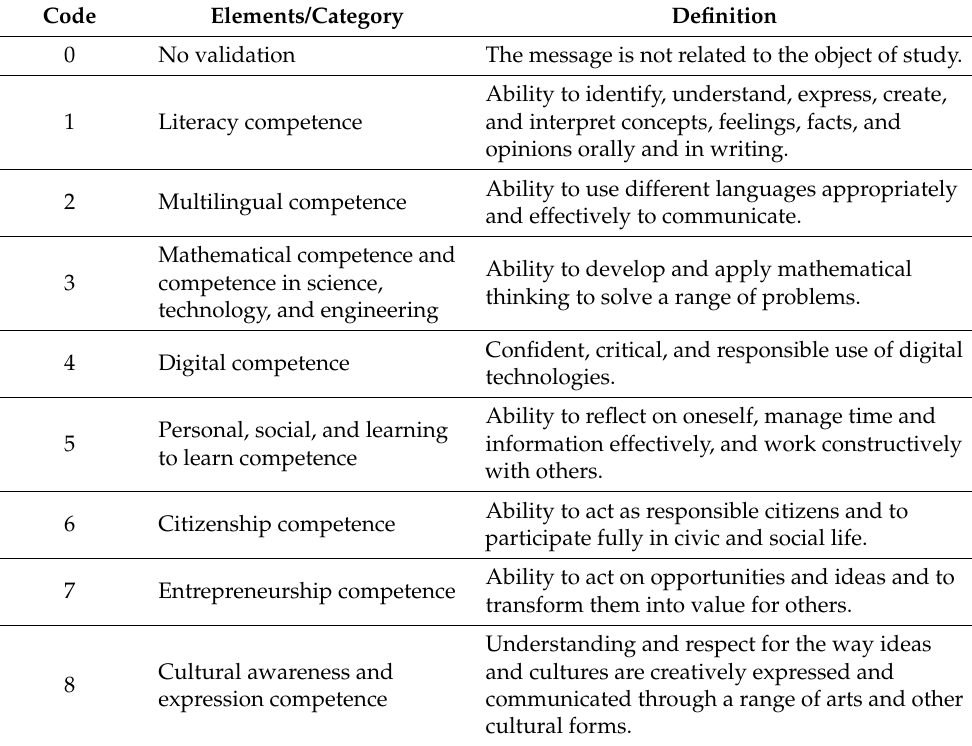
Table 2. Codebook for the SISM Methodology and the Categories for Analysis of the Communicative